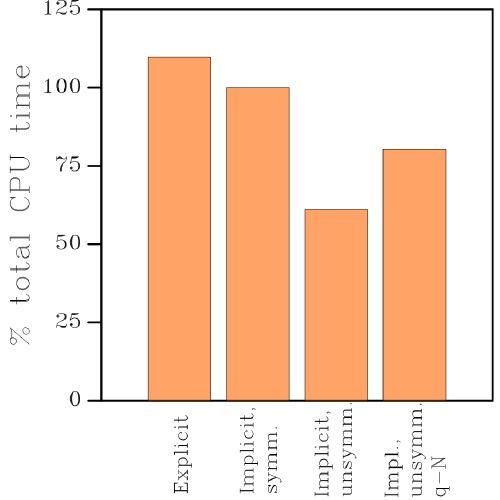
Figure 11. Real case test. Total computing